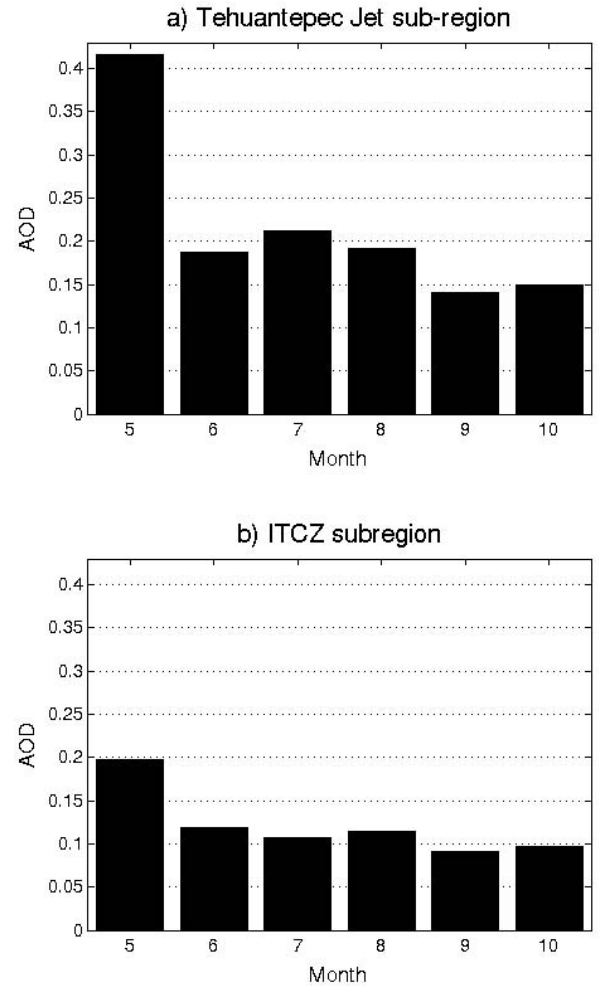
Fig. 12. Monthly variability of aerosol optical depth during rainy season averaged over the Tehuantepec Jet and the ITCZ sub-regions for years from 2000 to 2009 (Terra satellite) and from 2003 to 2009 (Aqua